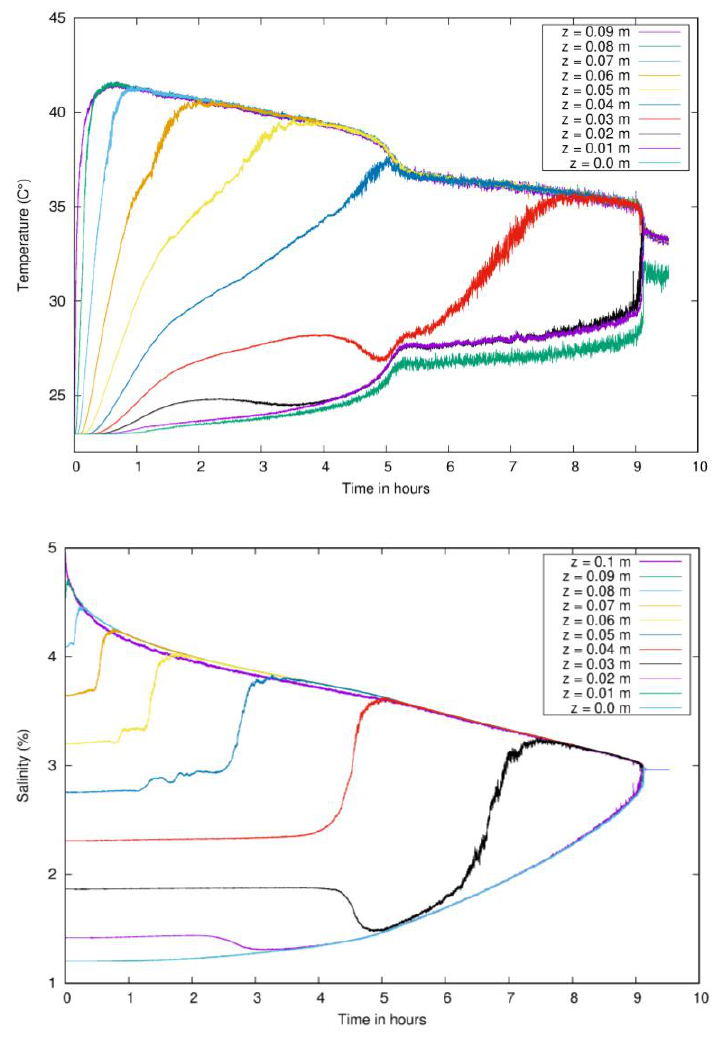
Figure 10. Time evolution of the temperature and salinity at several different depths.